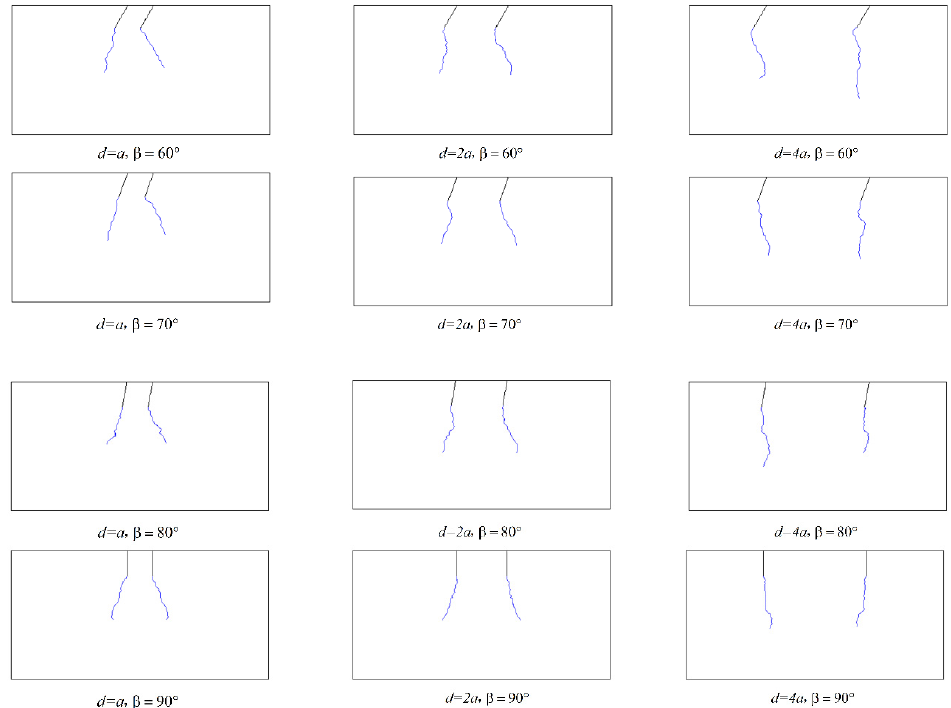
Figure 20. Effect of crack spacing and inclination angle on crack propagation.